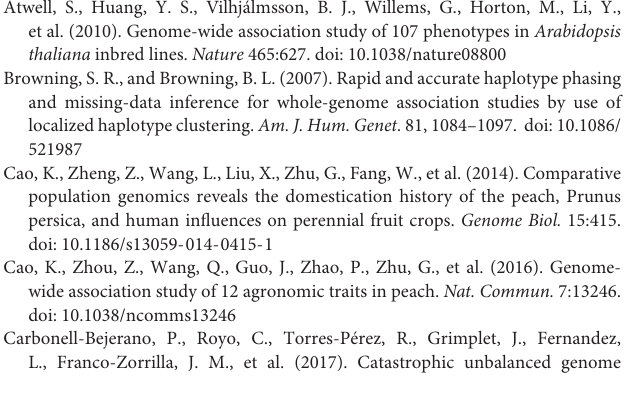
TABLE S5 | Additional 258 cultivated peach samples were phased at most association of SNP 26924482 bp of scaffold Pp06 from GWAS. TABLE S6 | In total 141 SRA runs from other prunus species excluding prunus persica were genotyped at most association of SNP 26924482 bp of scaffold Pp06 from GWAS. TABLE S7 | A first pair of primer was used to phase in additional 258 cultivated peach samples, and the rest primer pairs were to validate the origin of homozygous haplotype in bud